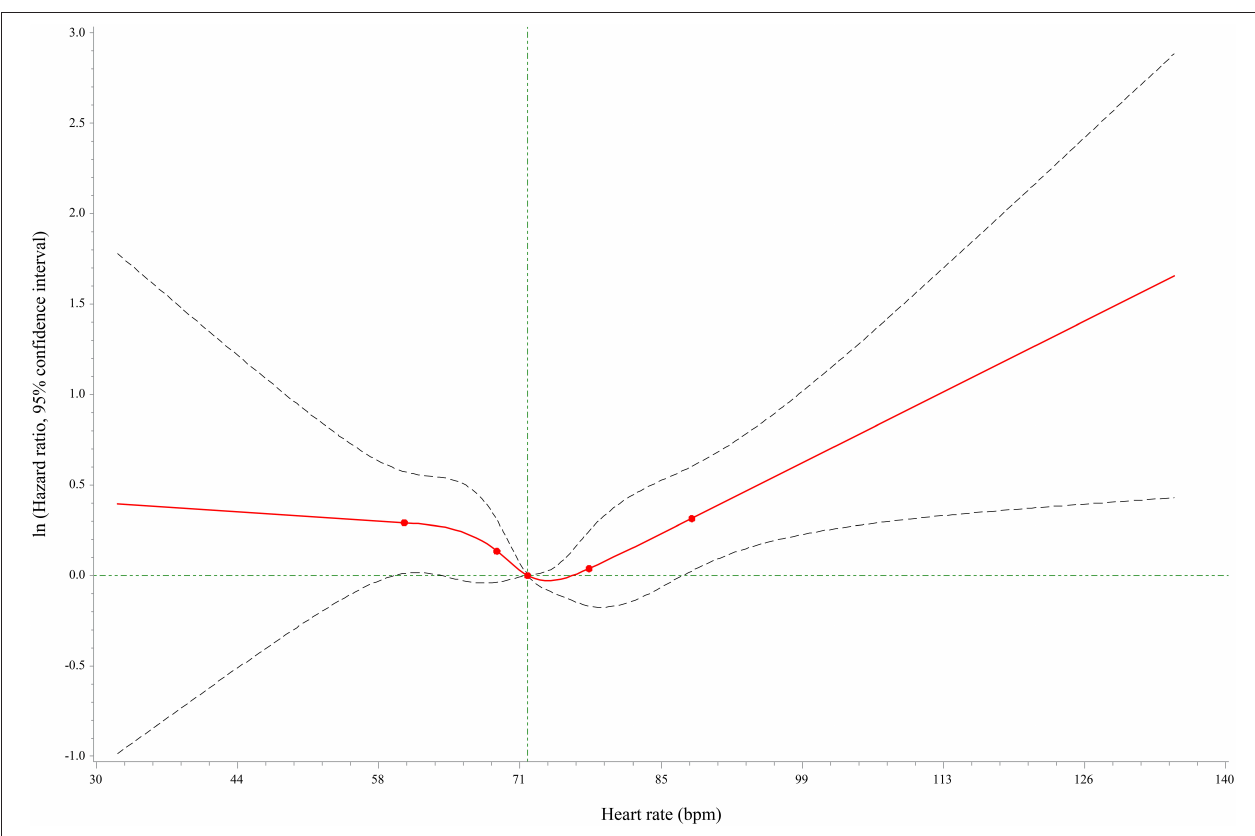
FIGURE 3 | RCS curve for the correlation between heart rate and MACE risks in hypertensive patients.